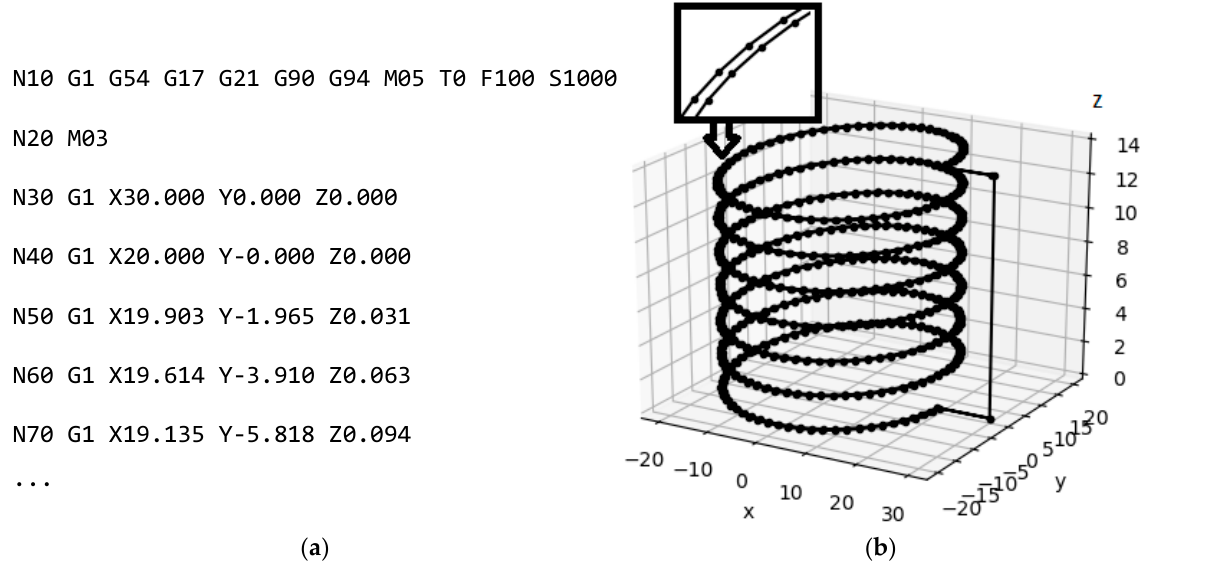
Figure 6. G-code snippet ( a ) and toolpath visualization with Matplotlib ( b ). The helix Points() function returns a list of helix points [63]. Its parameters are r —minimum radius; h —height; p —pitch; fi —taper angle; n —number of points on one turn; and z0 —axial displacement. The coordinates of the points are determined by the parametric helix equation.